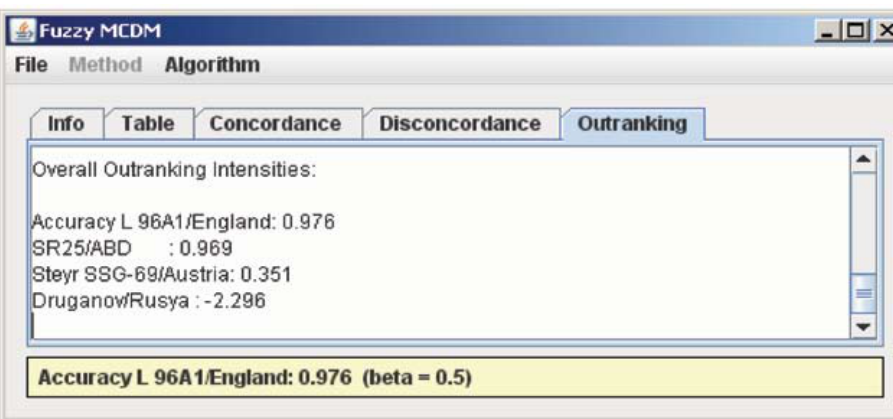
Fig. 8. Effects of reduced weights for C 4 , C 8 and C 9